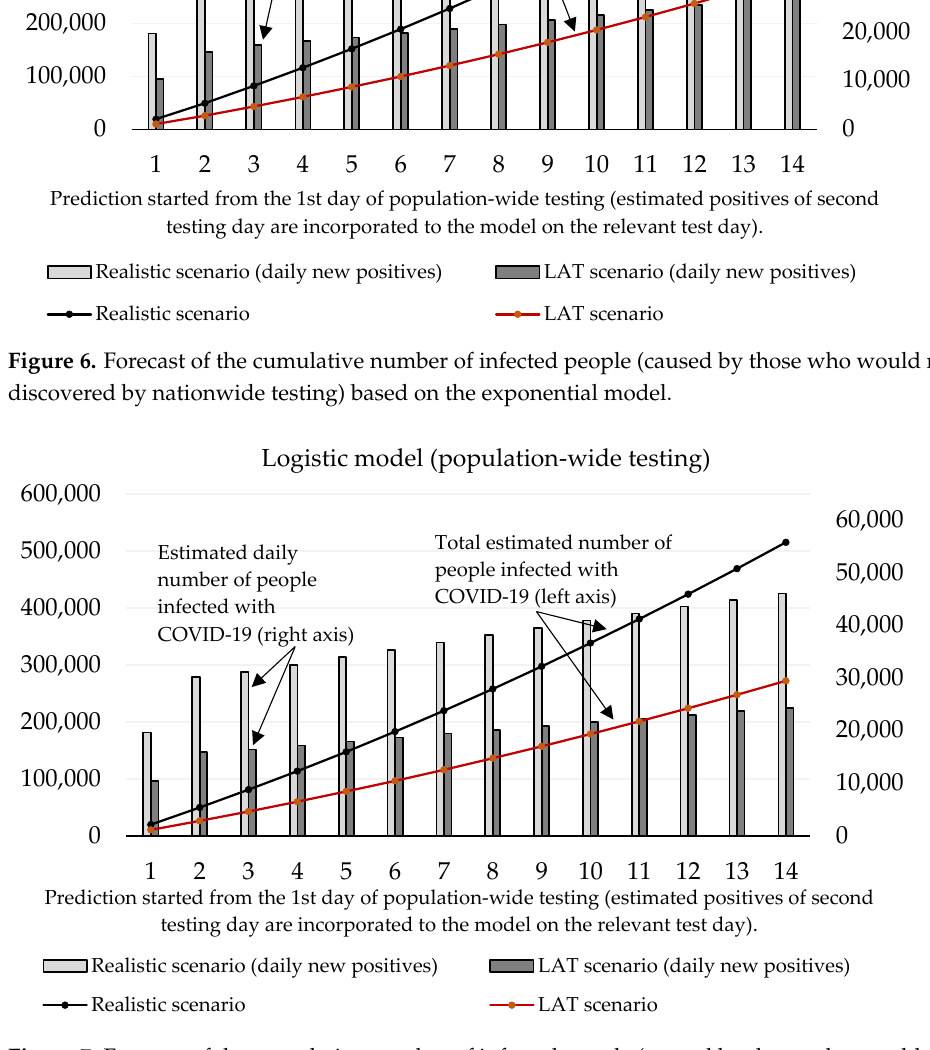
Figure 7. Forecast of the cumulative number of infected people (caused by those who would not be discovered by nationwide testing) based on the logistic model.